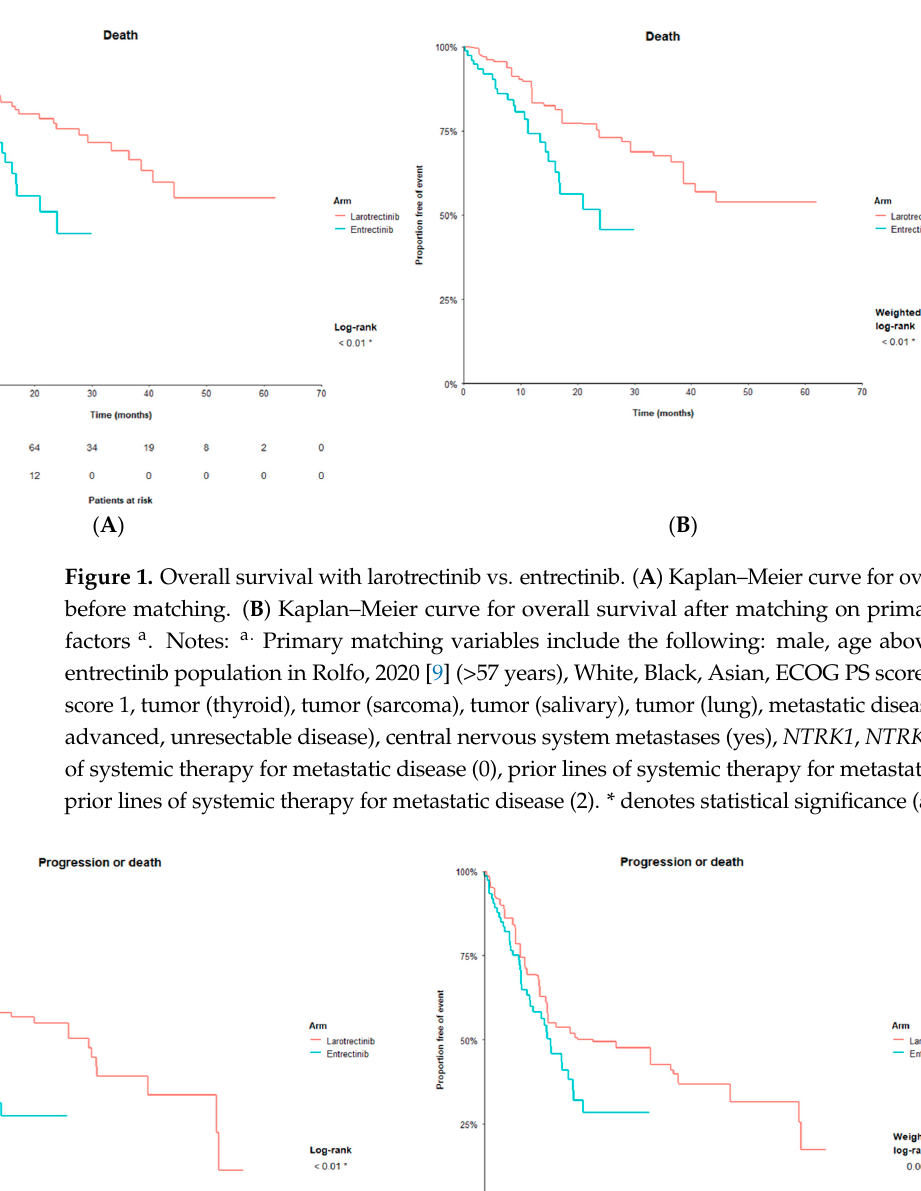
Figure 1. Overall survival with larotrectinib vs. entrectinib. ( A ) Kaplan–Meier curve for overall sur- vival before matching. ( B ) Kaplan–Meier curve for overall survival after matching on primary